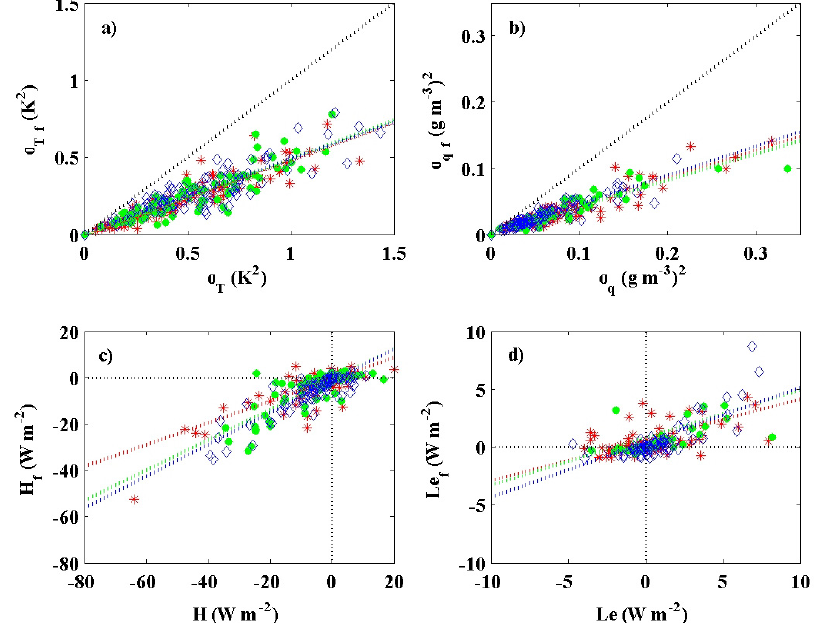
Figure 11. Same as Figure 10 but for the standard deviation of air temperature ( a ) and water vapour ( b ), sensible heat flux ( c ), and latent heat flux ( d